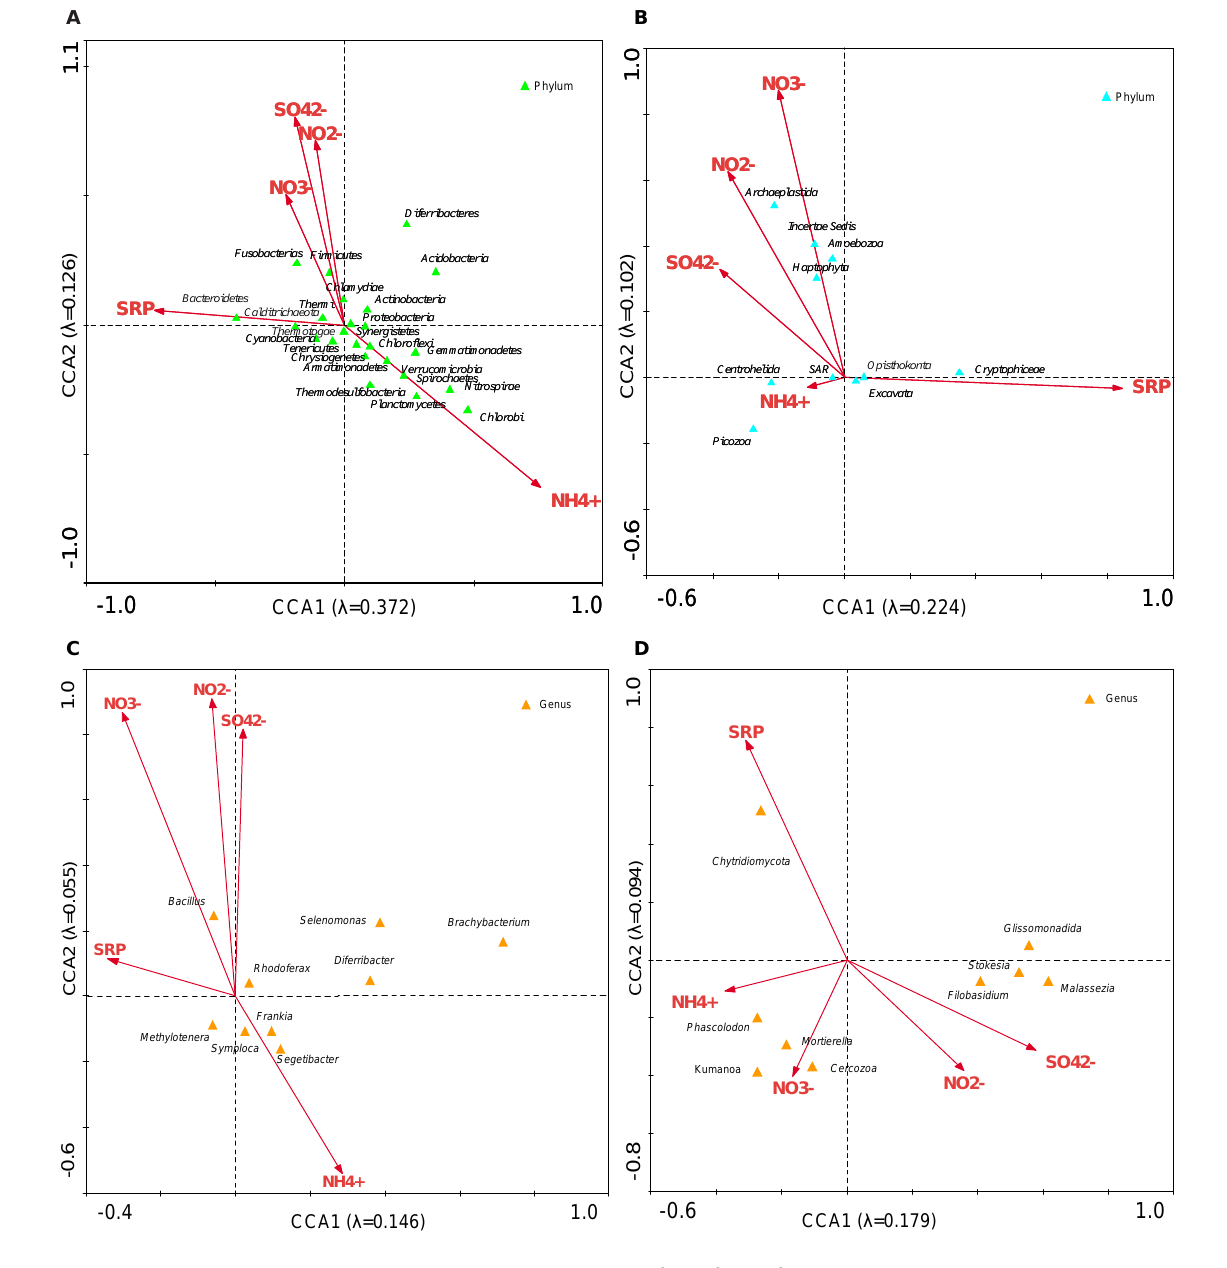
variables, respectively. When the age of the samples was